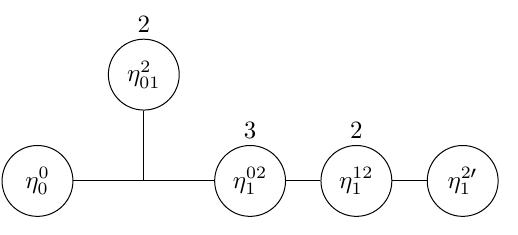
\ T , Resolution II. This (cid:12)ber is of 2 -model at S